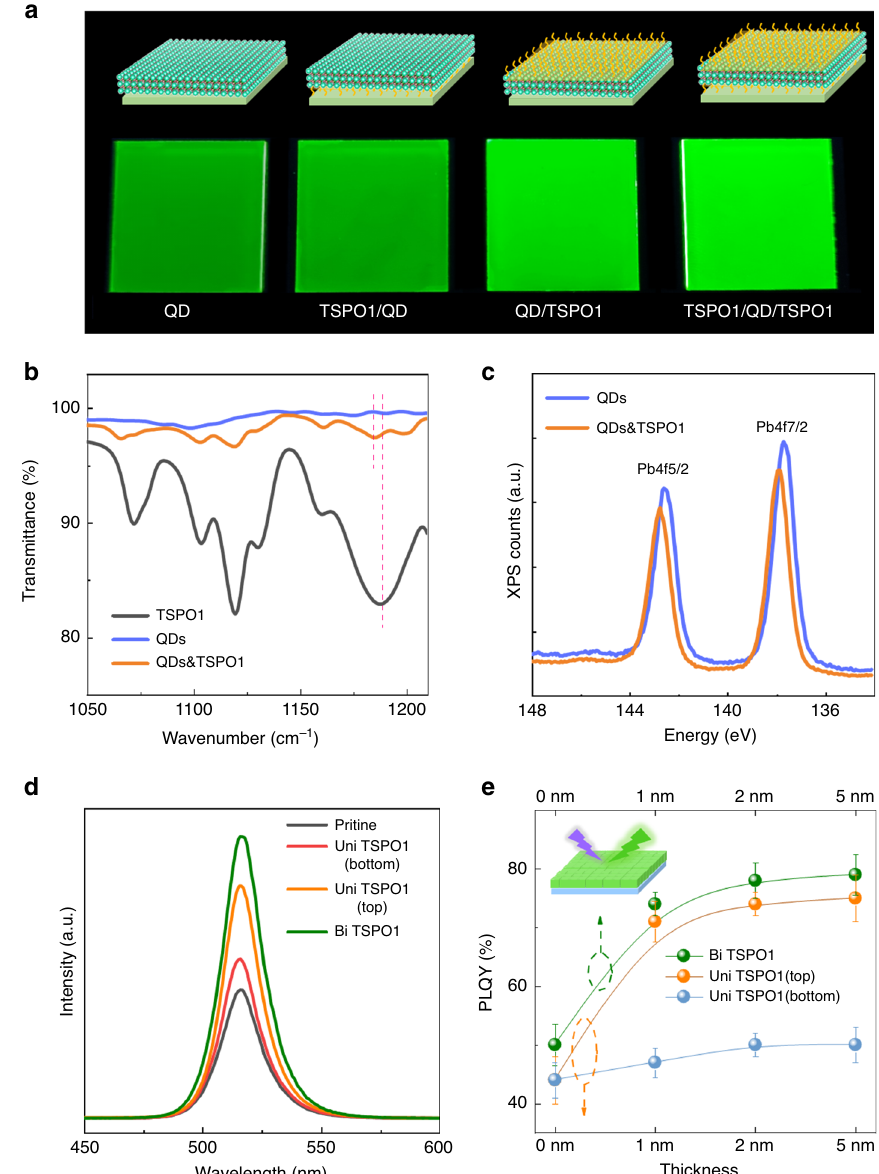
Fig. 2 PL property comparison of QD fi lms with different passivation states. a Schematic diagram and photograph of QD fi lms without passivation and with TSPO1 on the bottom side, on the top side, on both sides of QD fi lm under UV light. b Fourier transform infrared (FTIR) spectroscopy measurement for TSPO1, QD and TSPO1-QD fi lms prepared on silicon wafers. c Pb 4 f core level XPS spectra of primal and TSPO1-passivated CsPbBr 3 QD fi lms. d PL spectra and ( e ) PLQY of QD fi lms without and with TSPO1 on the bottom side, on the top side, on both sides of QD fi lm. Error bars represent standard deviation of experimental data acquired from three times. Source data are provided as a Source Data fi